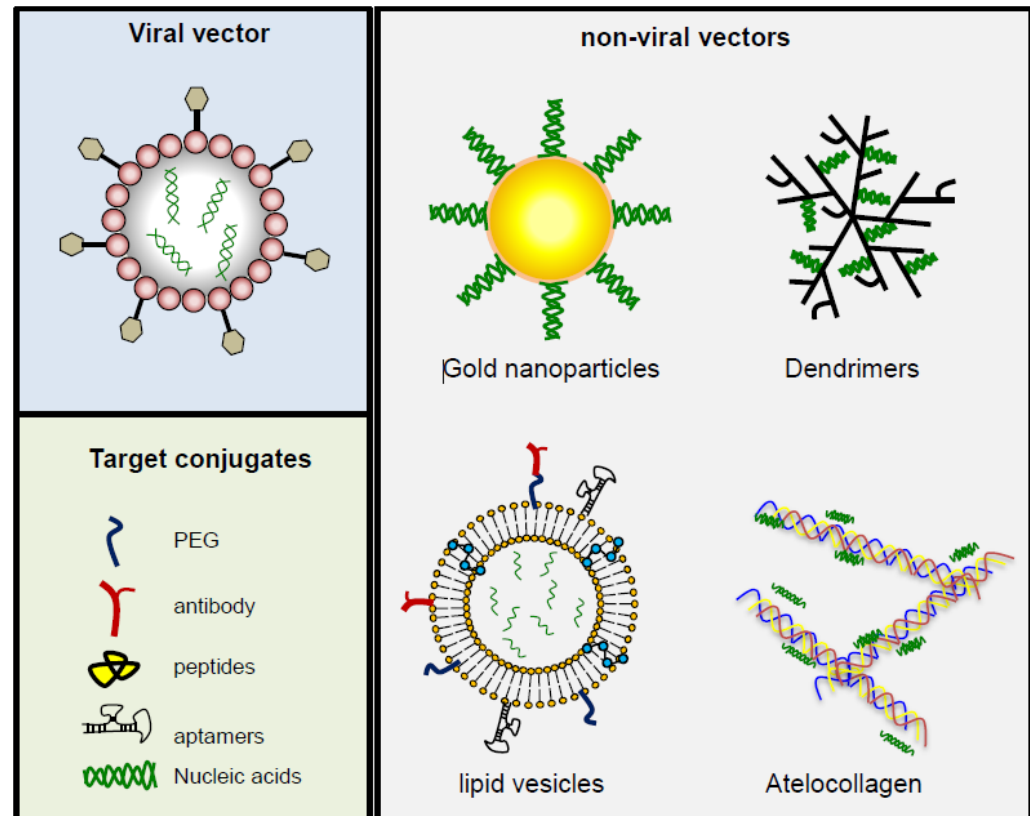
Figure 2. Schematic description of delivery shuttles developed to increase the stability and efficiency of systemic delivery of oligonucleotides. Viral vectors are very efficient but immunogenic. Non-viral vectors are less immunogenic but have faulty inefficiency, toxicity, and lack specificity. Different strategies have been developed to overcome these obstacles. Conjugation with PEG makes these vectors more stable and, to enhance specificity, they can be combined with peptides, antibodies, or peptides that recognize a target on the cell surface.